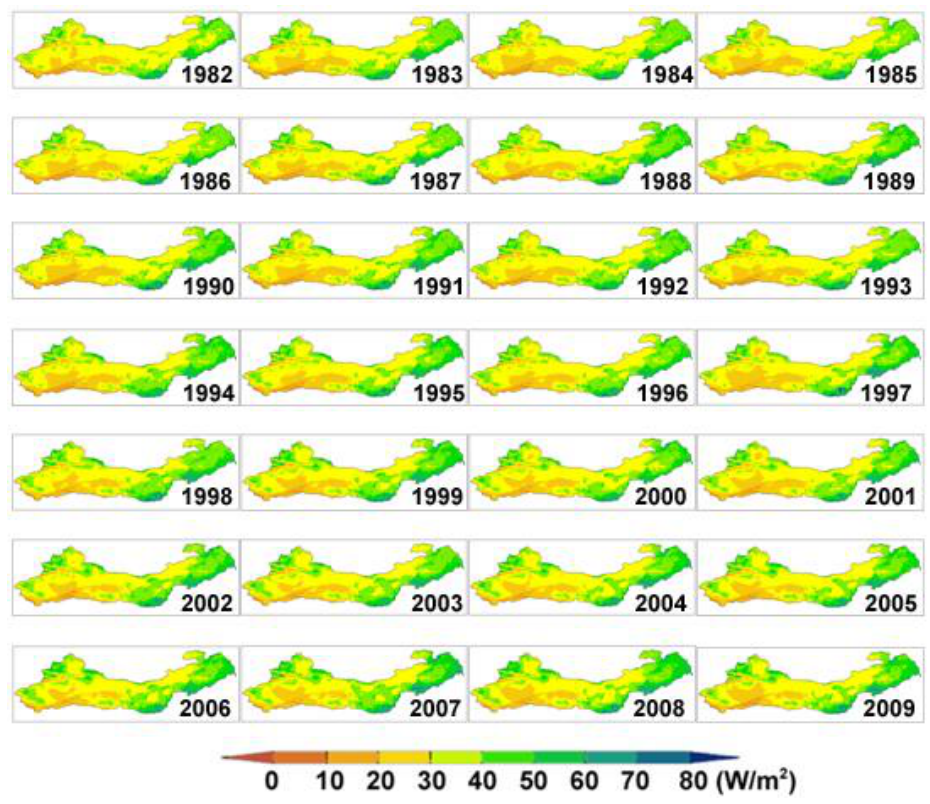
Figure 7. Map of annual composites of monthly LE over Three-North Shelter Forest Region of China for